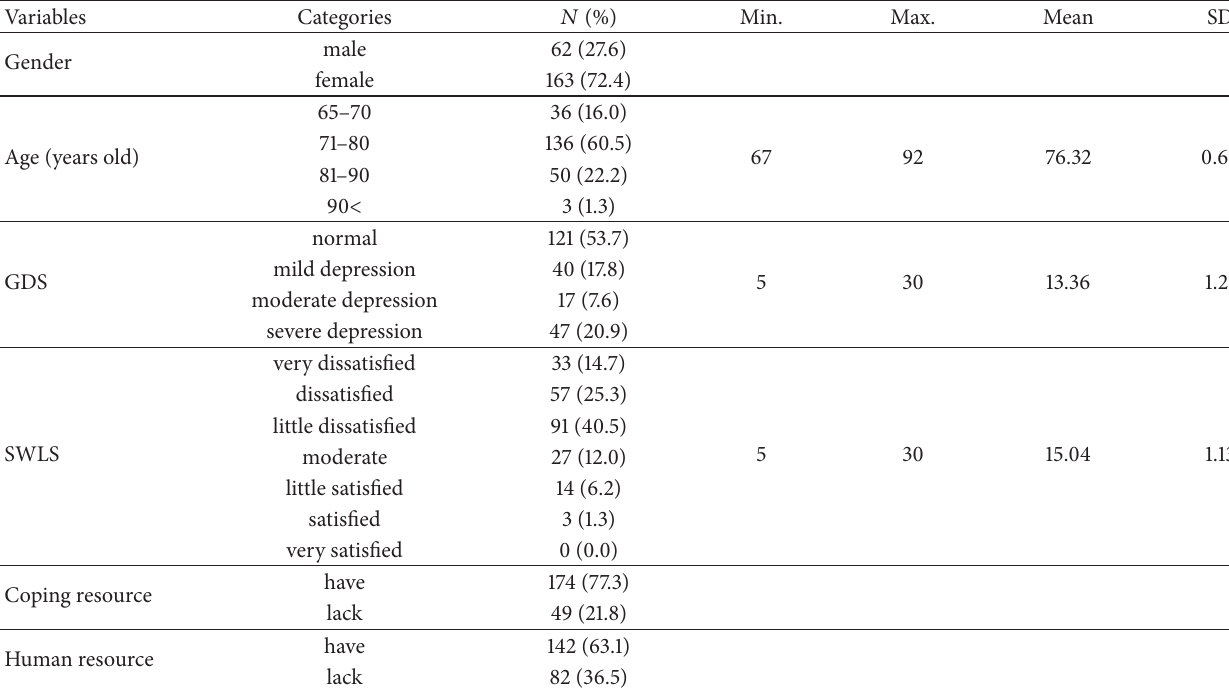
Table 1: Characteristics and variables of subjects ( 𝑁 = 225